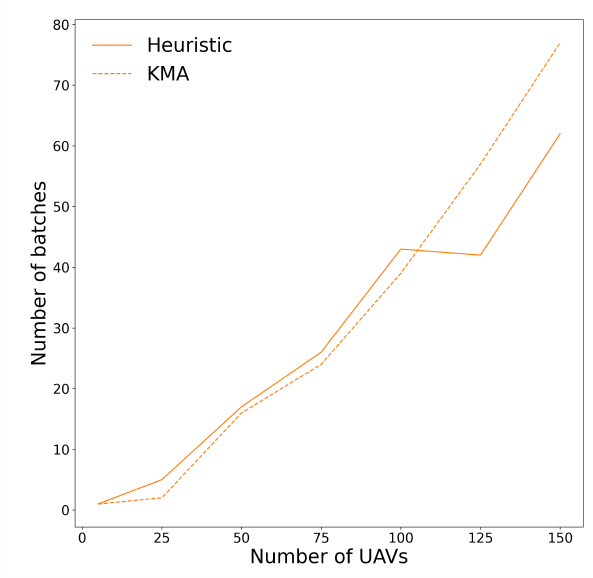
Figure 23. Number of batches between heuristic and KMA in the circular